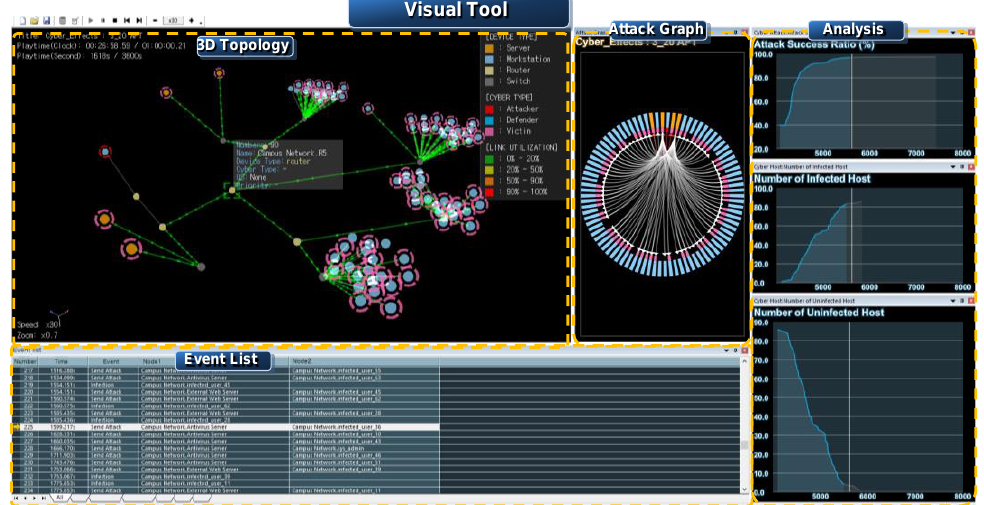
Figure 11. Training situation visualization.